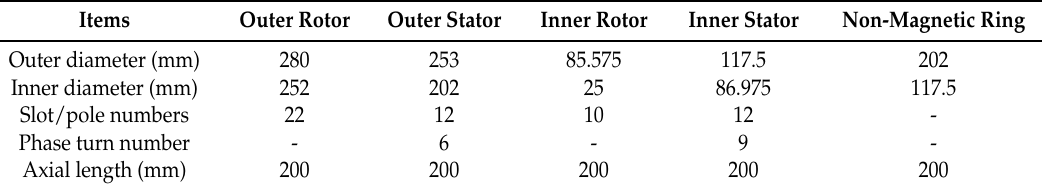
Table 3. Size parameters of the DMP machine.